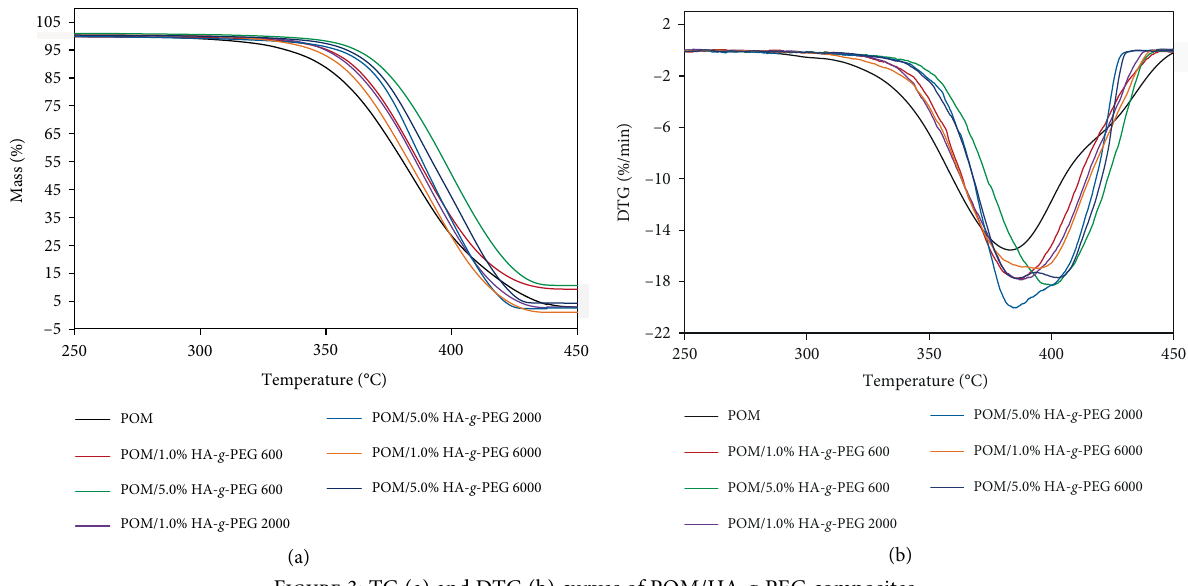
Figure 3: TG (a) and DTG (b) curves of POM/HA- g -PEG